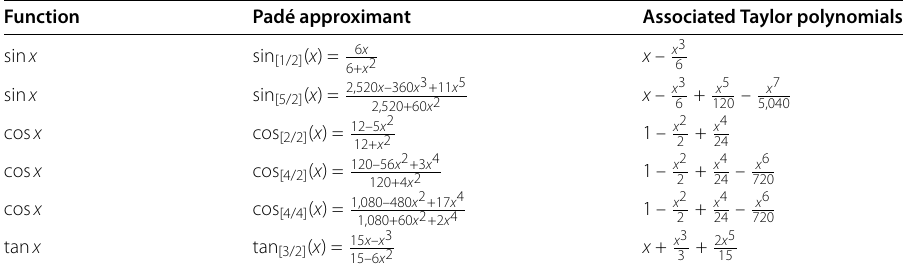
Table 1 We present the first orders of Pade approximant for sin x , cos x , tan x